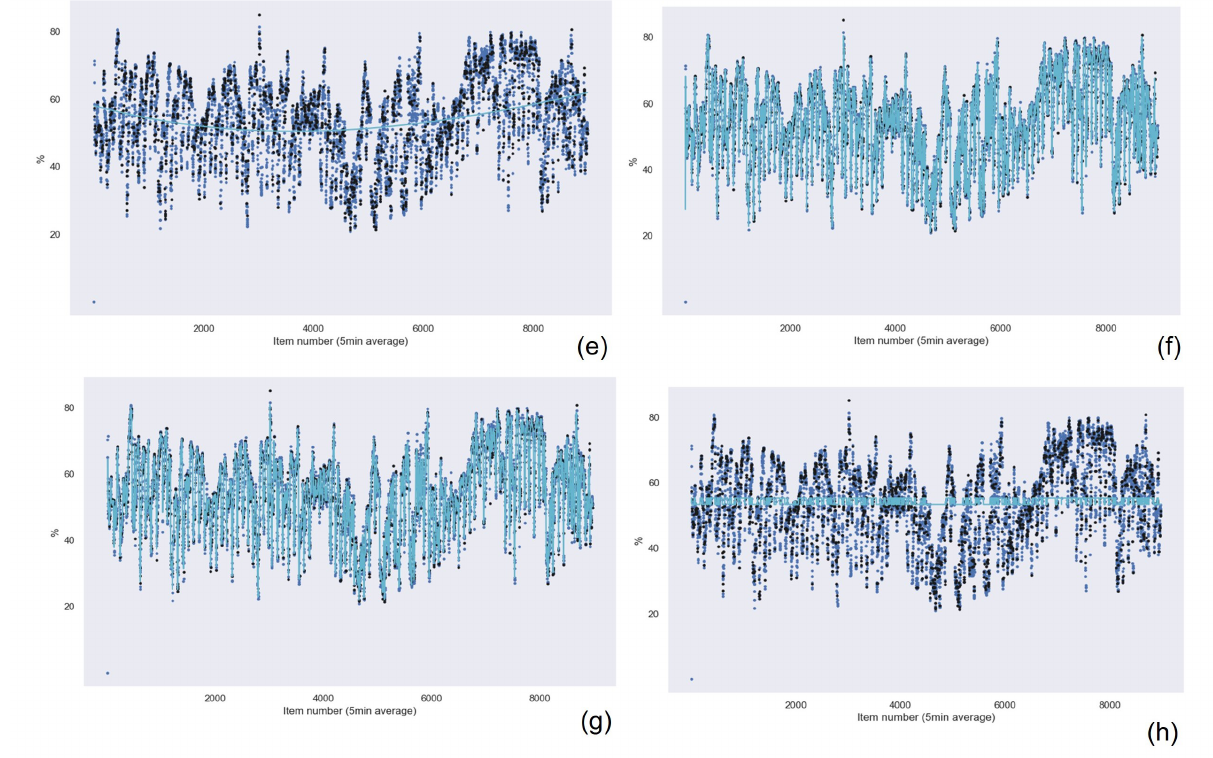
Figure A19. Humidity results of the articulate matter measuring device # 2 with outliers for ( a ) Linear Regression ( b ) Random Forest Regression ( c ) KNN and ( d ) Support Vector Machine, and without out- liers for ( e ) Linear Regression ( f ) Random Forest Regression ( g ) KNN and ( h ) Support Vector